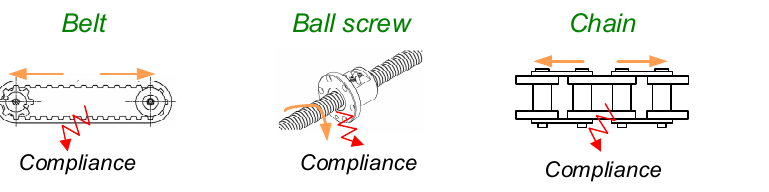
Figure 12. Capacitive energy storage schematic diagram of the ETD.